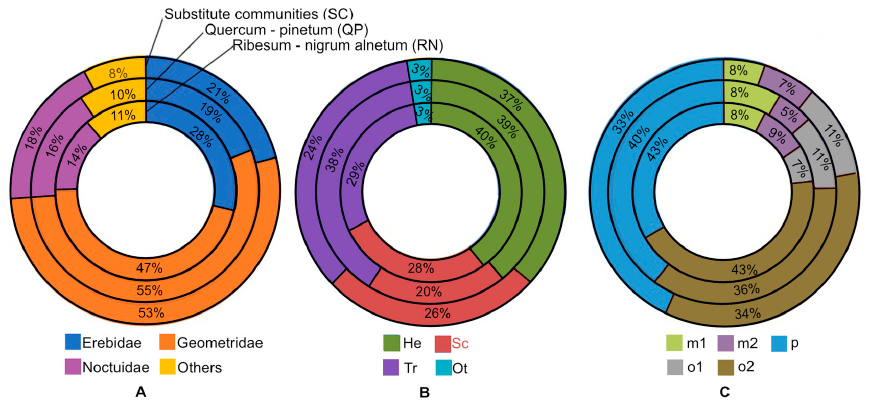
Figure 5. Share of individuals per family in each forest (NNP, Podlaskie, North-East Poland) plant community according to: the family they represent ( A ); the plant type ( B ) and to their plant specificity ( C ) m1-1st degree monophagous, m2-2nd degree monophagous, o1-1st degree